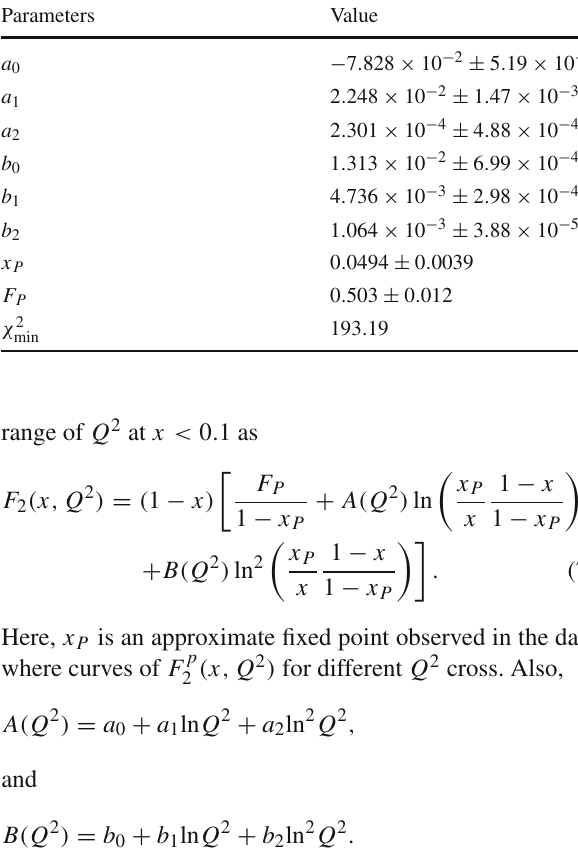
Table 1 The effective parameters at low x for 0 . 11 GeV 2 < Q 2 < 1200 GeV 2 are defined by the following values Parameters